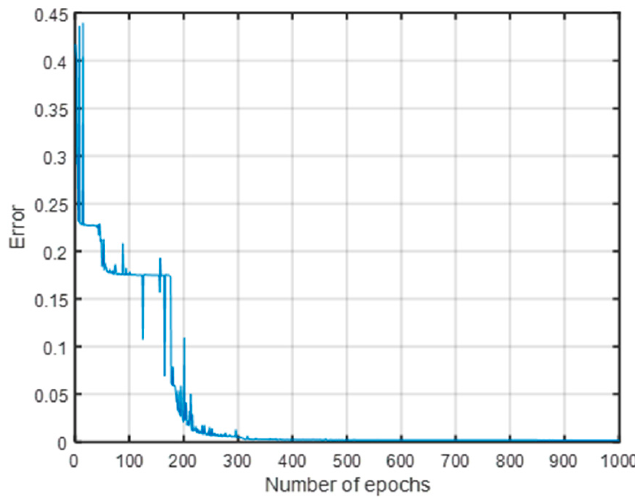
Figure 9. Error to iterations of the fault classification training set.